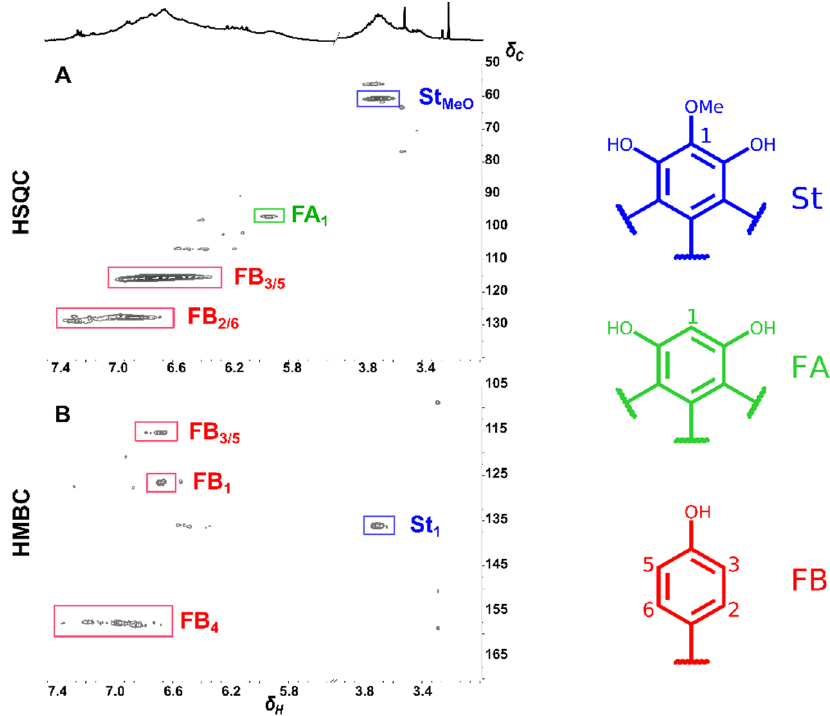
Figure 2. 2D-HSQC- ( A ) and 2D-HMBC-NMR ( B ) spectra (in acetone- d 6 :D 2 O, 7:3) of the polymeric fraction (YS poly) isolated from Y. schidigera cortex. Top black trace: 1 H NMR spectrum of YS poly.